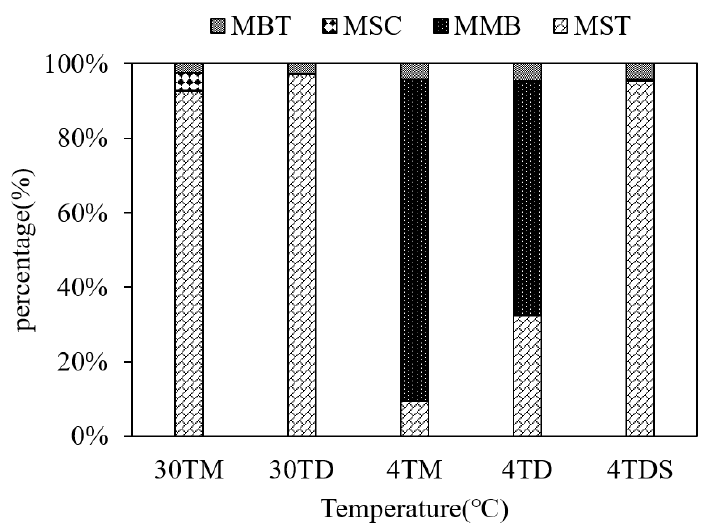
Figure 4. Quantitative PCR of methanogens in adhering sludge and settled sludge. Granular biomass samples from seed inoculum, adherent sludge, and settled sludge were assayed. S = sample of seed sludge; TM = adherent sludge; TD = settled sludge; TDS = sludge sample after reactor souring; MBT = Methanobacteriales; MSC = Methanosarcinaceae; MMB = Methanomicrobiales; MST = Methanosaetaceae.